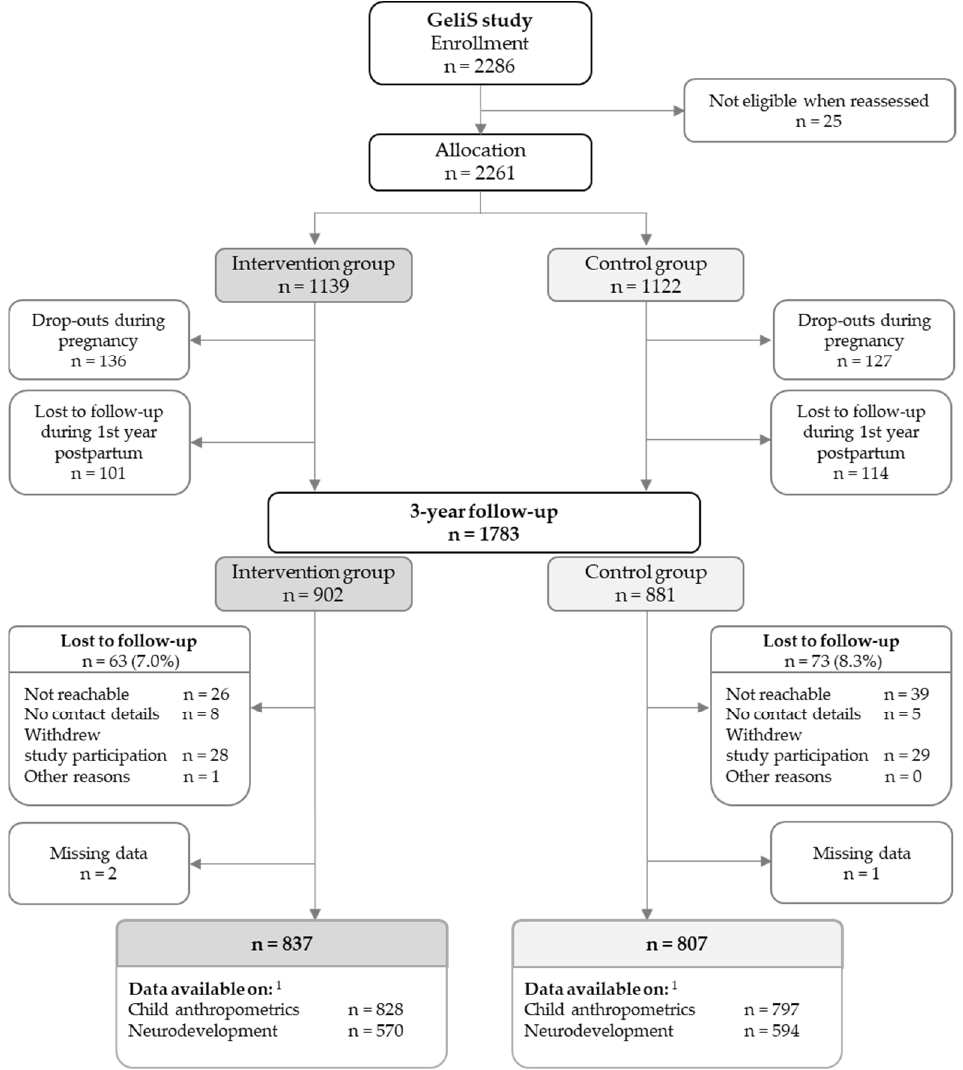
Figure 1. Flow of study participants. 1 Participants who provided data on both child anthropometrics and neurodevelopment: intervention group: n = 561; control group: n = 584.